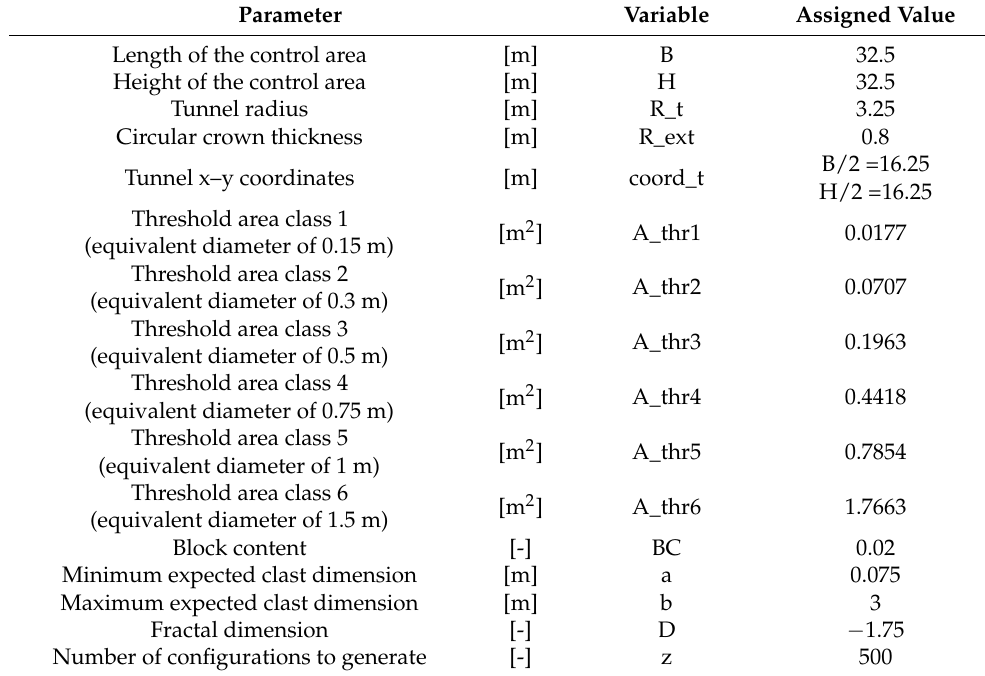
Table 1. Input parameters for the probabilistic analysis.